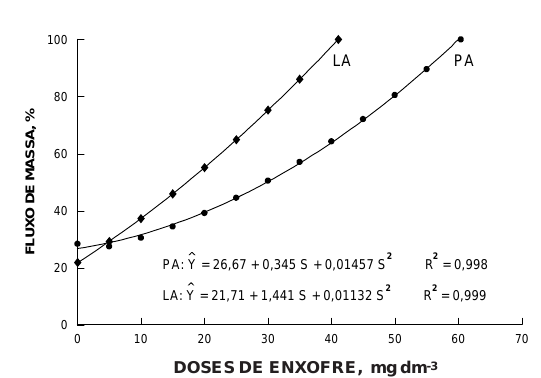
Figura 2. Contribuição percentual do fluxo de massa na absorção de enxofre por plantas de milho, em função das doses de S aplicadas em amostras dos solos de Paracatu (PA) e Lassance